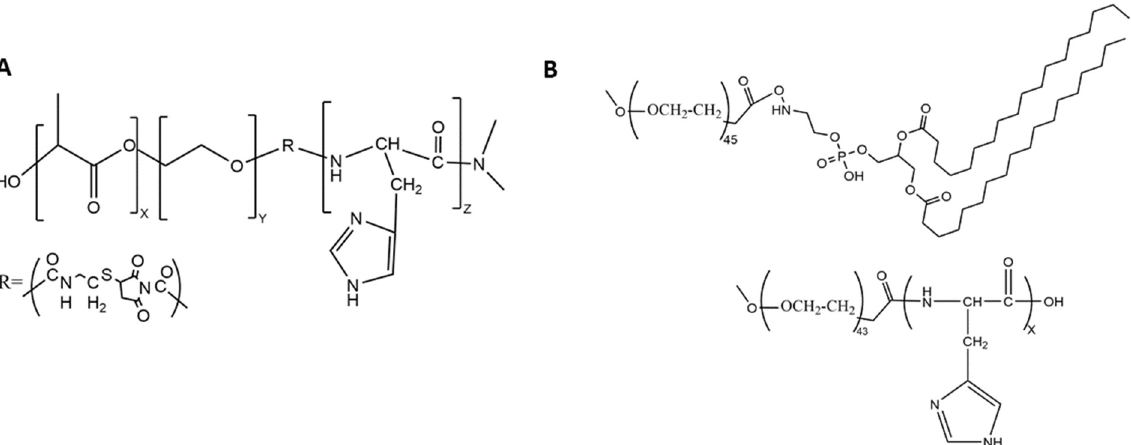
Figure 2. Chemical structures of the ( A ) triblock copolymer and ( B ) the block copolymers mPEG-PLH and PEG-DSPE, which formed micelles. The numbers of monomeric units in the block copolymer are represented by X, Y, and Z.